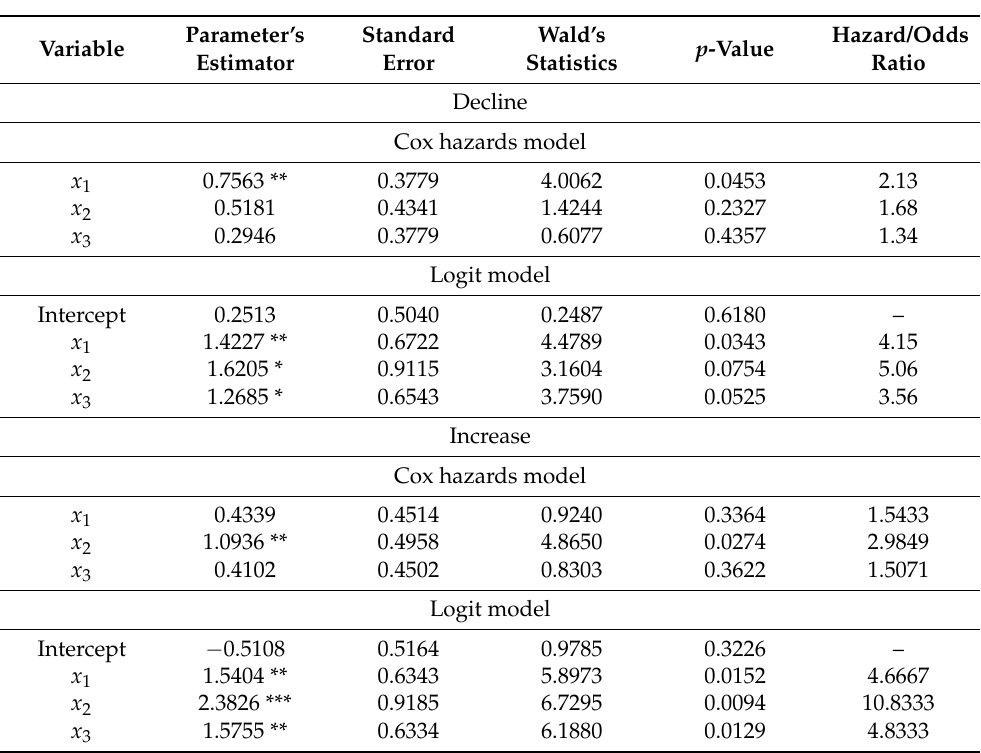
Table 4. Results of the Cox hazards model and the logit model parameters estimation ( N = 108). Source: own